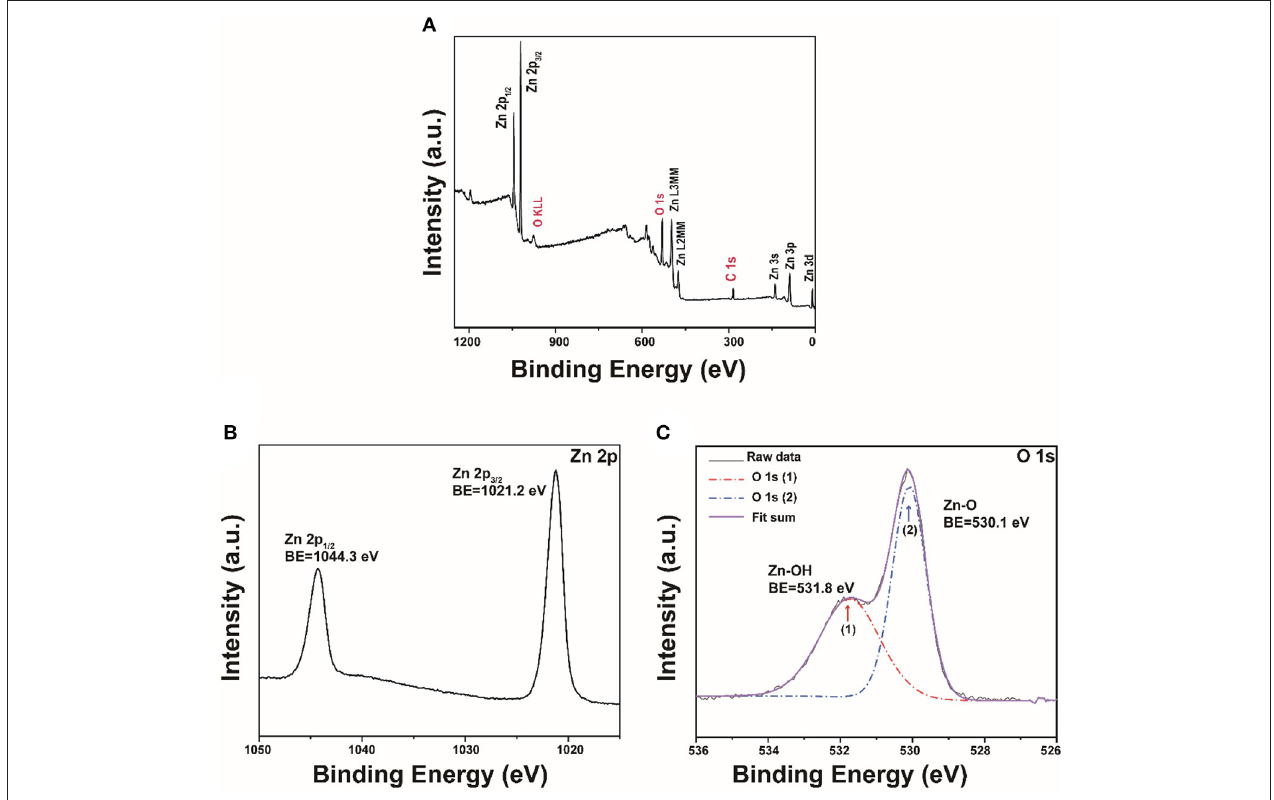
FIGURE 3 | (A) XPS survey of the porous ZnO; The high-resolution XPS spectra: (B) Zn 2p and (C) O 1s.